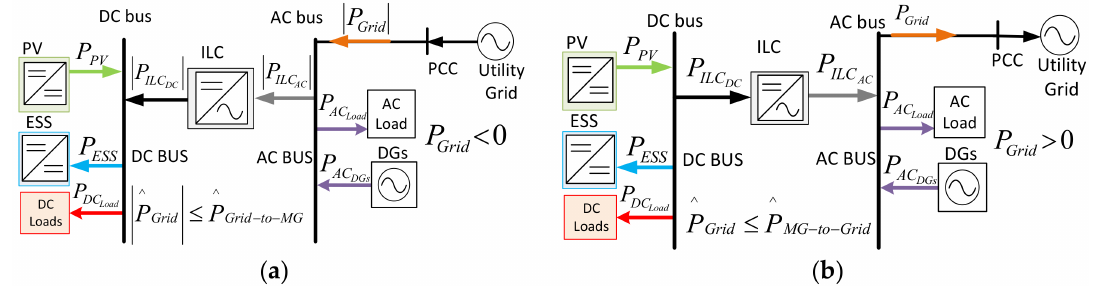
Figure 2. Power flow scenarios between the grid and the MG: ( a ) power flow from the grid to the MG, P Grid < 0; ( b ) power flow from the MG to the grid, P Grid >